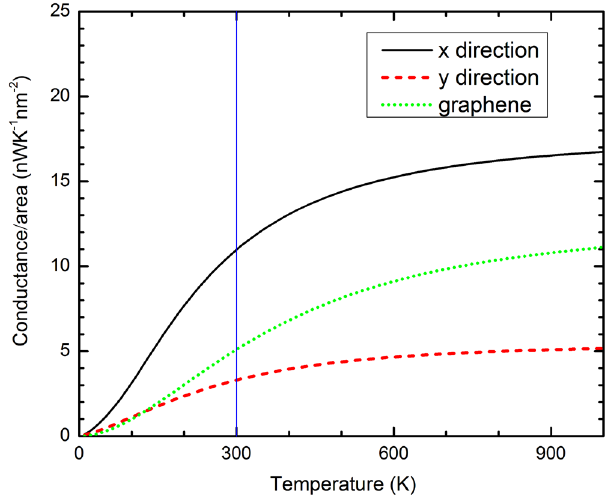
Fig. 6 Temperature-dependent thermal conductance of β 12 bor- ophene and graphene. The thickness of borophene is taken as the diameter of boron atom. For graphene, the thickness is the interlayer distance ( δ = 3.4 Å)